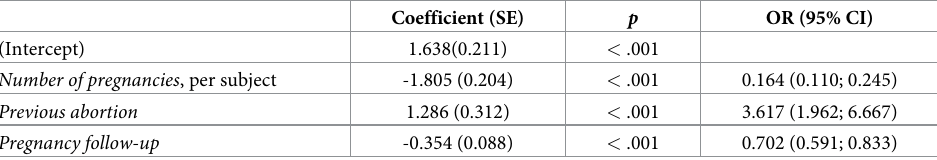
Table 4. Multivariate binomial regression for the teenage motherhood.